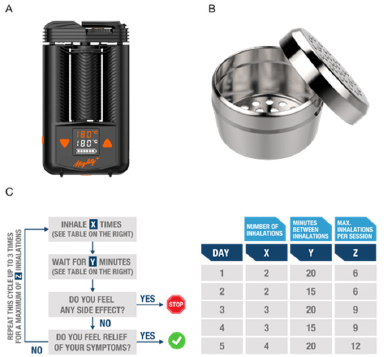
Figure 1. Proposed protocol to initiate naïve patients and prescribing doctors safely into the inhala- tion of THC-predominant cannabis flos. ( A ) The herbal vaporizer mightly medic is powered by rechargeable batteries and attained EU-mark as a medical device; ( B ) Pharma-grade aluminum dosing capsules holding up to 0.25 g of grinded cannabis flos can be loaded into the mighty heating unit. ( C ) Flowchart depicting a proposed 5-day familiarization plan for naïve users, with daily increases in number and frequency of inhalations to minimize the risk of CNS-related side effects.